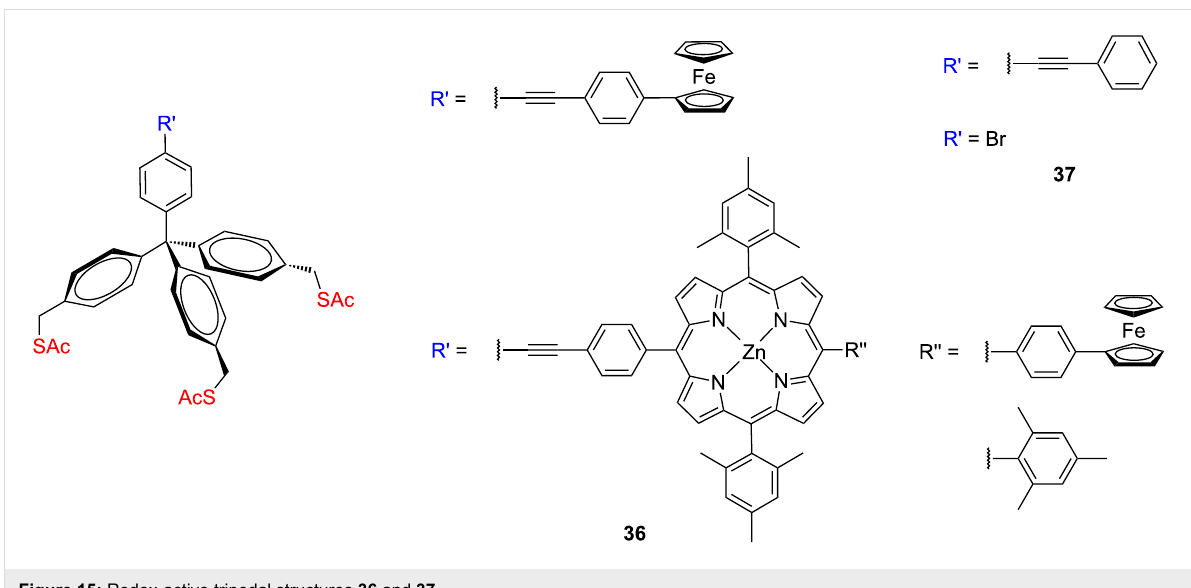
Figure 15: Redox-active tripodal structures 36 and 37 .